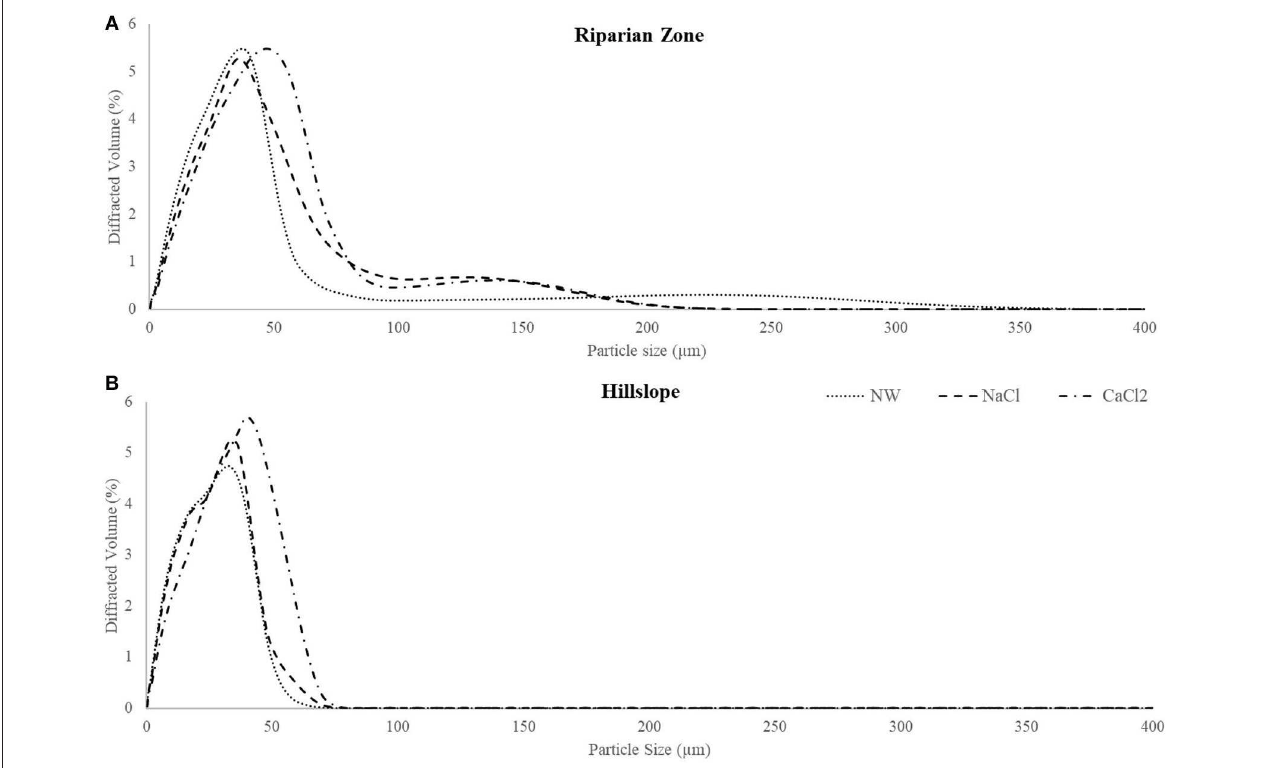
FIGURE 4 | Distribution of average particle size by treatment for landscape positions, RZ (A) and the HS (B) . There is a shift to the left in peaks from higher ionic strength to lower ionic strength solution. NW, Nanopure Water; NaCl, sodium chloride; CaCl 2 , calcium chloride.